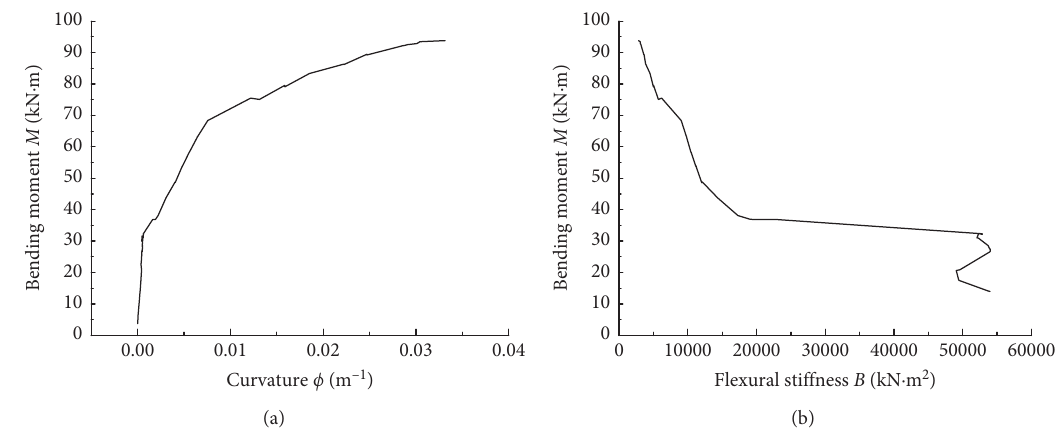
Figure 5: B-1-30-4. (a) Bending moment-curvature curve. (b) Bending moment-stiffness curve.